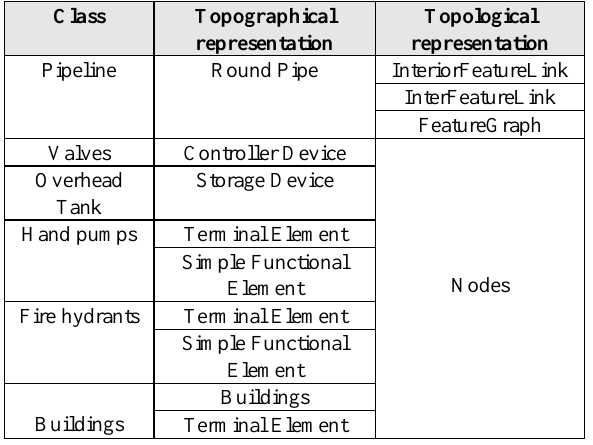
Table 3. Mapping Subsurface Features to CityGML Feature Classes Table 4: Mapping of classes to tables for Water Supply Data